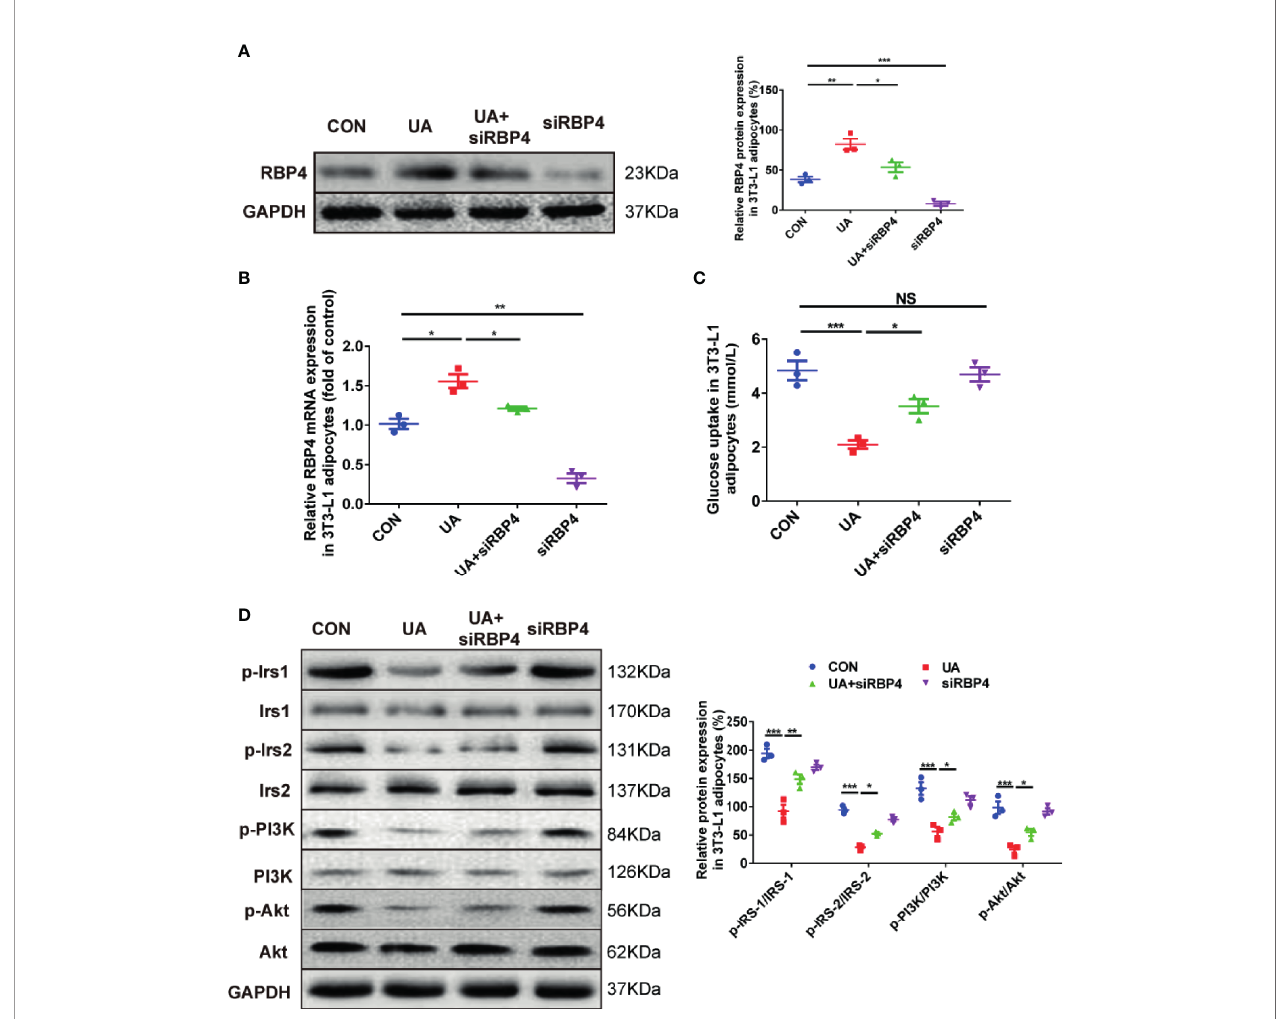
FIGURE 3 | The effects of RBP4 on glucose uptake and phosphorylation of IRS/PI3K/Akt in UA-induced 3T3-L1 adipocytes. 3T3-L1 adipocytes were treated with UA (10 mg/dl), RBP4 siRNA (50nM), or UA+RBP4 siRNA for 48h. (A) About 30 m g protein were loaded and the expression of RBP4 was examined by western blot. The representative views are shown in the left panel and densitrometric quanti fi cation analysis for RBP4 is shown in the right panel. (B) The mRNA expression of RBP4 was determined by RT-PCR. (C) Glucose uptake was determined by a glucose test kit. (D) About 30 m g protein were loaded and the expression of p-IRS-1 (PY896), p-IRS-2 (S731), p-PI3K (P85), and p-Akt (Ser473) were determined by western blot. The representative views are shown in the left panel and densitrometric quanti fi cation analysis for RBP4 is shown in the right panel. Results are represented by mean ± SEM. * P < 0.05, ** P < 0.01, *** P < 0.001. NS, not signi fi cant. All the experiments were repeated three